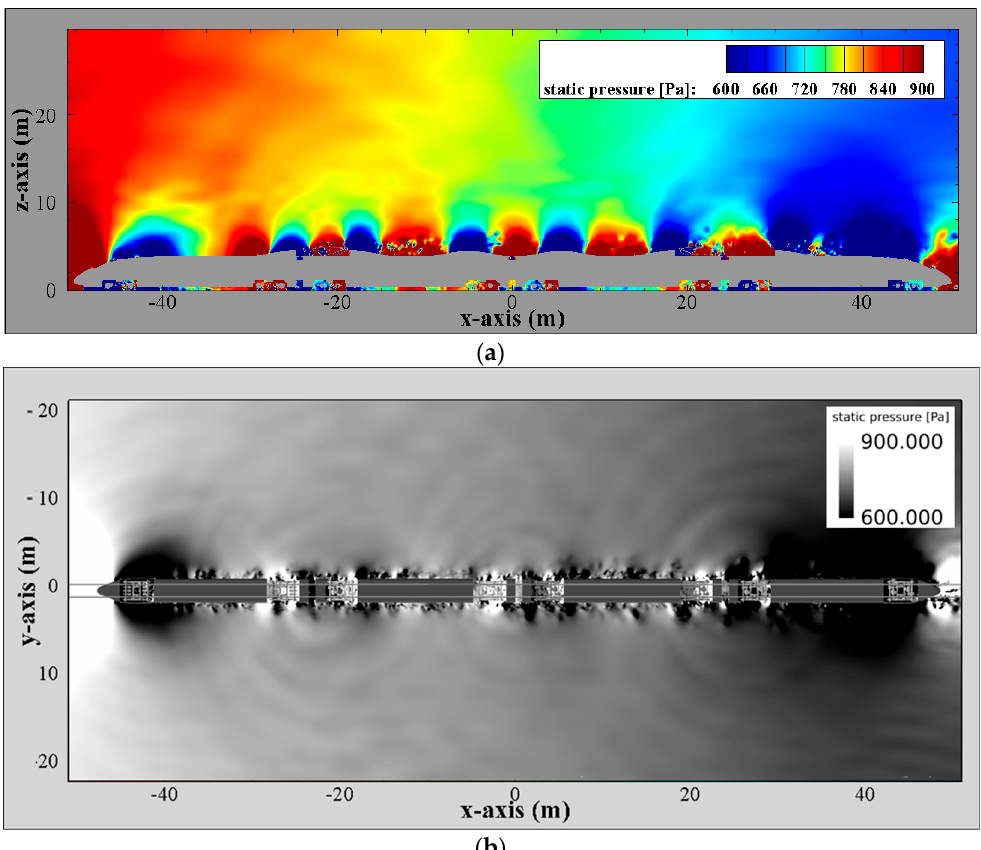
Figure 7. Instantaneous static pressure contour: ( a ) x–z plane, y = 0 m; ( b ) x–y plane, z = 1 m.